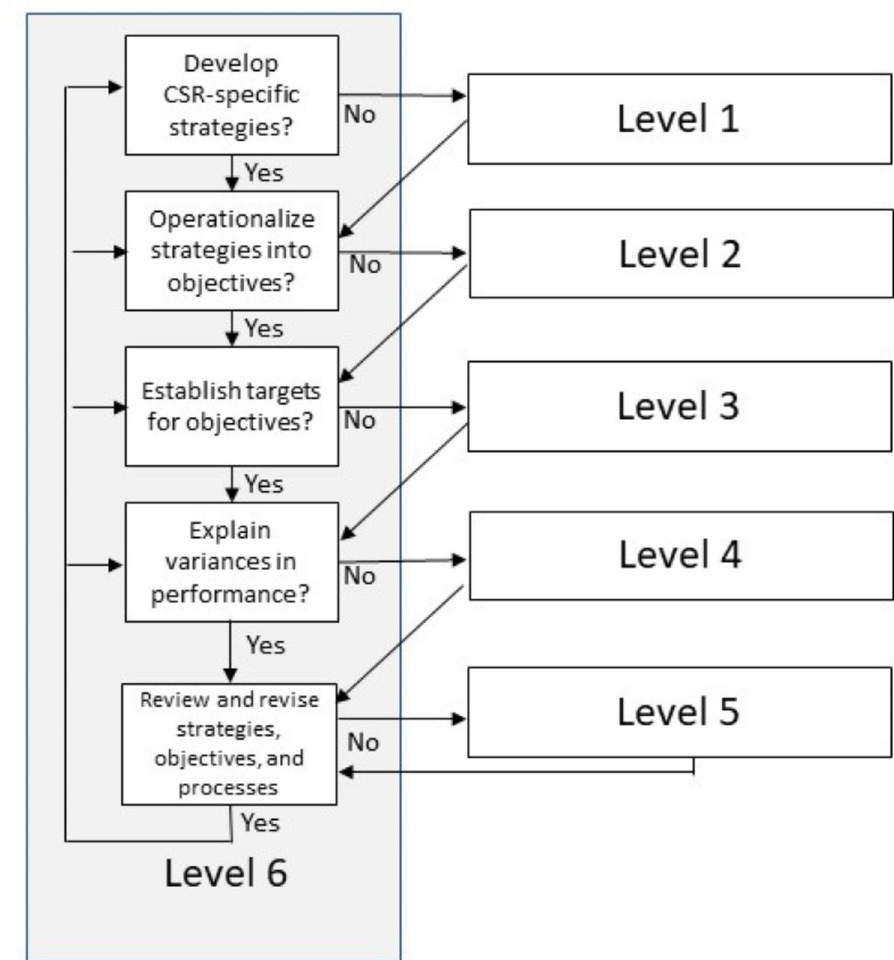
Fig. 1 Strategic CSR Integration